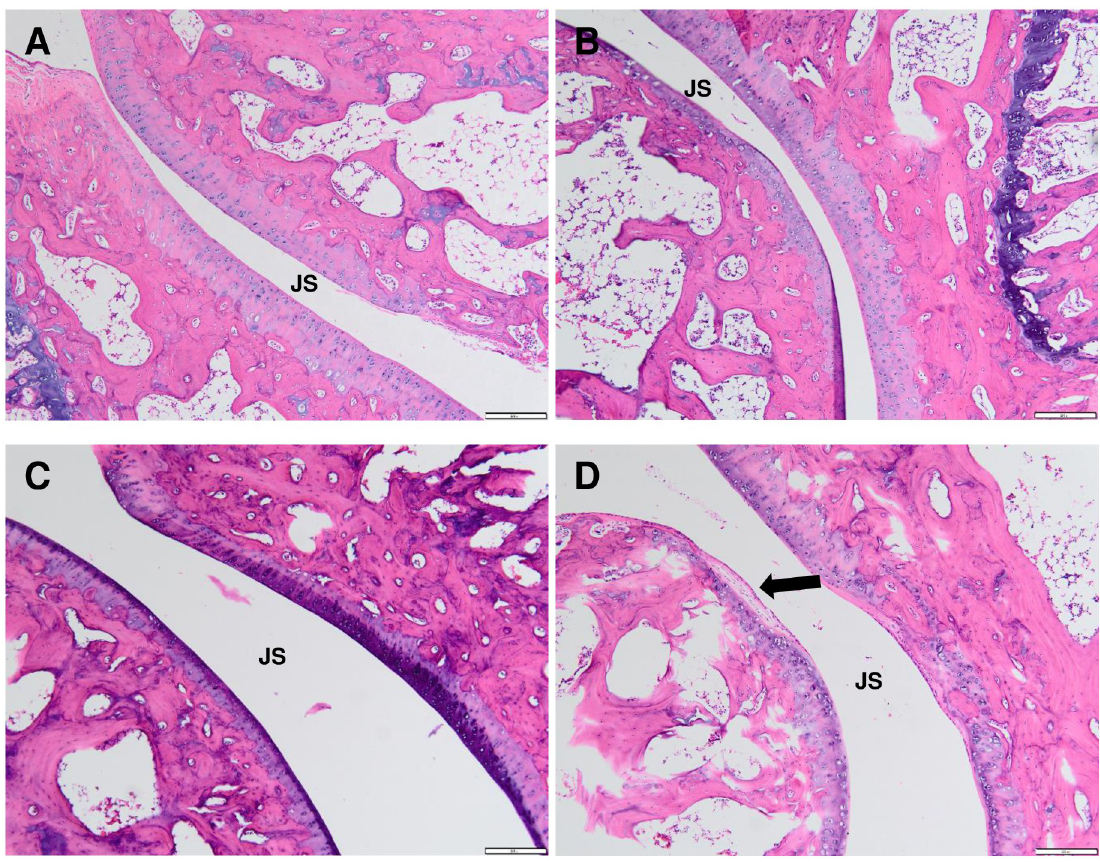
Fig 10. Histological sections of contralateral ankle joint by haematoxylin and eosin (H&E) staining at 40x magnification in control (A), polyarthritic rat inoculated with CFA at 5.0 mg/mL (CFA 5.0) (B), 7.5 mg/mL (CFA 7.5) (C) and 10.0 mg/mL (CFA 10.0) (D). (A) Like the ipsilateral ankle joint, the control rat exhibited normal joint cartilage structure, regular joint space with the normal connective tissue of the synovial membrane. CFA 5.0 group did not demonstrate prominent inflammatory cells penetration in the regular joint space. Meanwhile, the inflammatory cells infiltration was identified between the joint space (arrow) of the CFA 7.5 (C) and CFA 10.0 (D) groups, although it was not as extensive as the ipsilateral ankle joint.